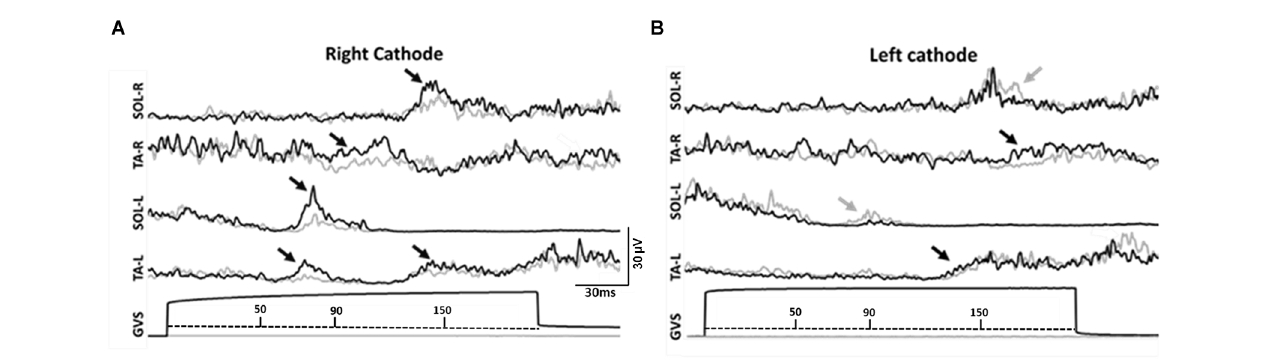
FIGURE2 (A) Right cathode configuration. (B) Left cathode configuration. GVS stimulation during early stance produced SLR, MLR, and LLR in all muscles tested. Black arrows indicate facilitatory response, gray arrows indicate inhibitory response. 50 ms ≤ onset of Short Latency Response (SLR) ≥ 90 ms; 90 ms ≤